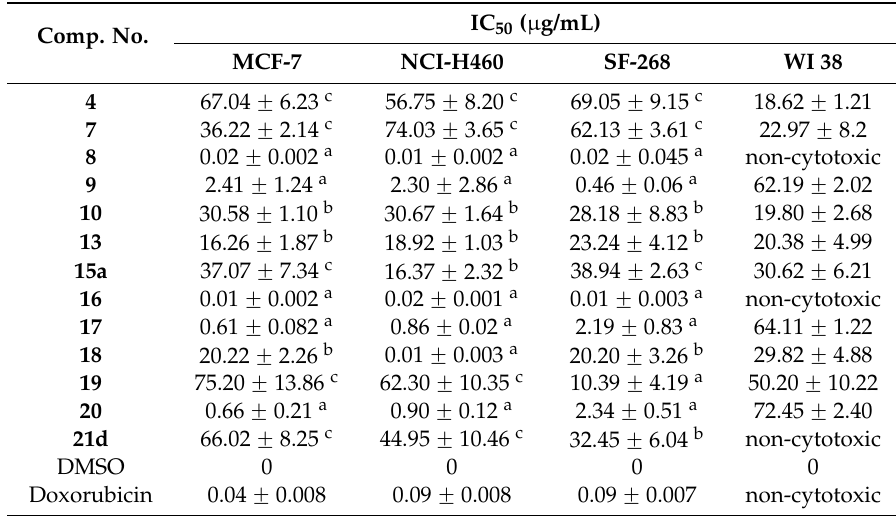
Table 1. Cytotoxic activity in (IC 50 , µ g/mL) by the newly synthesized compounds against human cancer cell lines and normal cells. Comp.